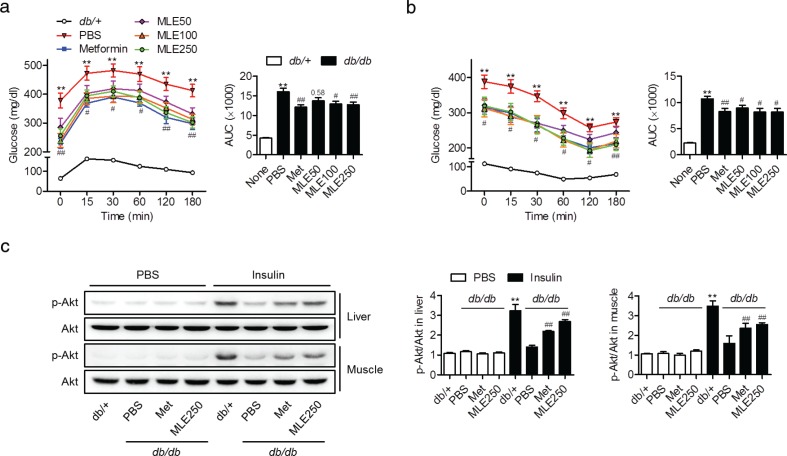
Effects of MLE supplementation on insulin sensitivity in db/db mice. At the 7th week, glucose concentrations during oral glucose tolerance tests (a) and insulin tolerance tests (b) were measured. Areas under the curve were compared (n = 7/each group). (c) At the end of the study, insulin-stimulated Akt phosphorylation was measured in the liver and skeletal muscle. The band intensities of p-Akt and Akt were quantitated (n = 3/each group). Values are expressed as mean±SEM. **p < 0.01 versus db/+ or db/+ with PBS, #p < 0.05 and ##p < 0.01 versus db/db+PBS or db/+ with insulin.